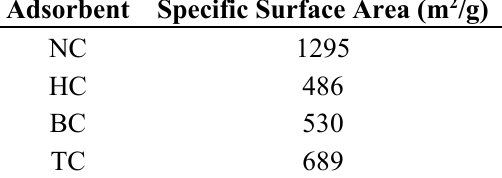
Table 2. Specific Surface Areas determined by the methylene blue method adsorption for all the